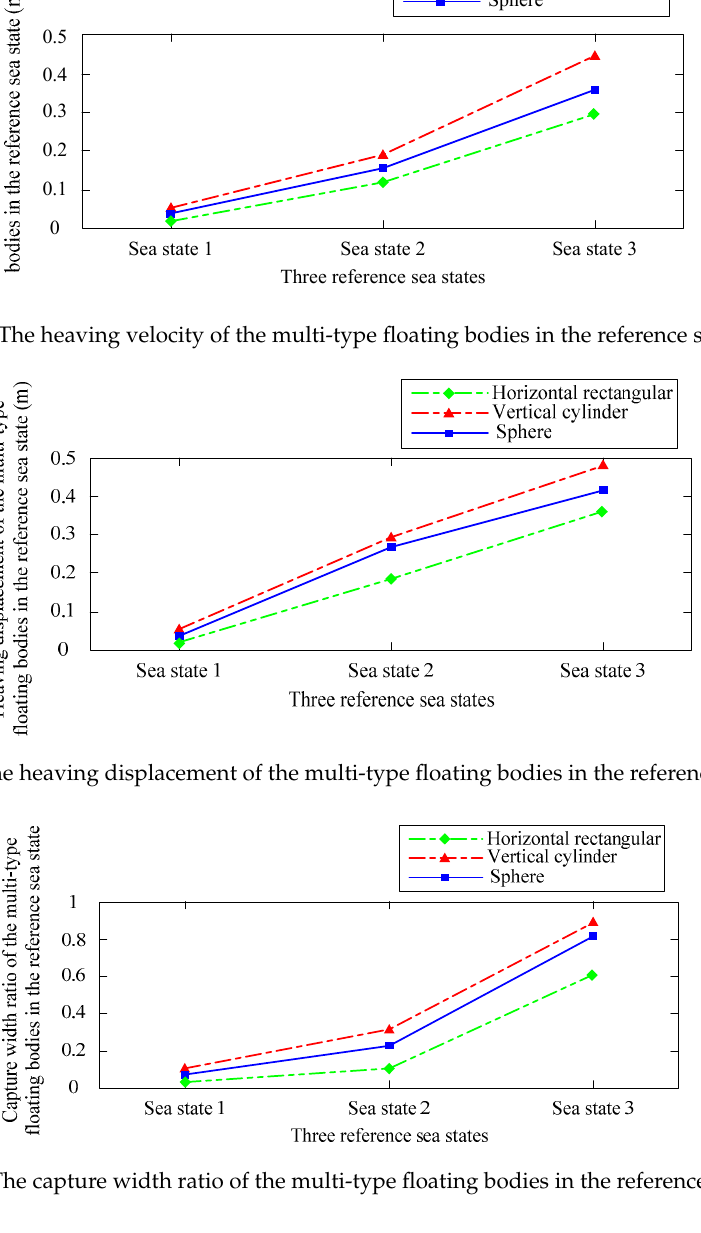
Figure 11. The capture width ratio of the multi-type floating bodies in the reference sea state.